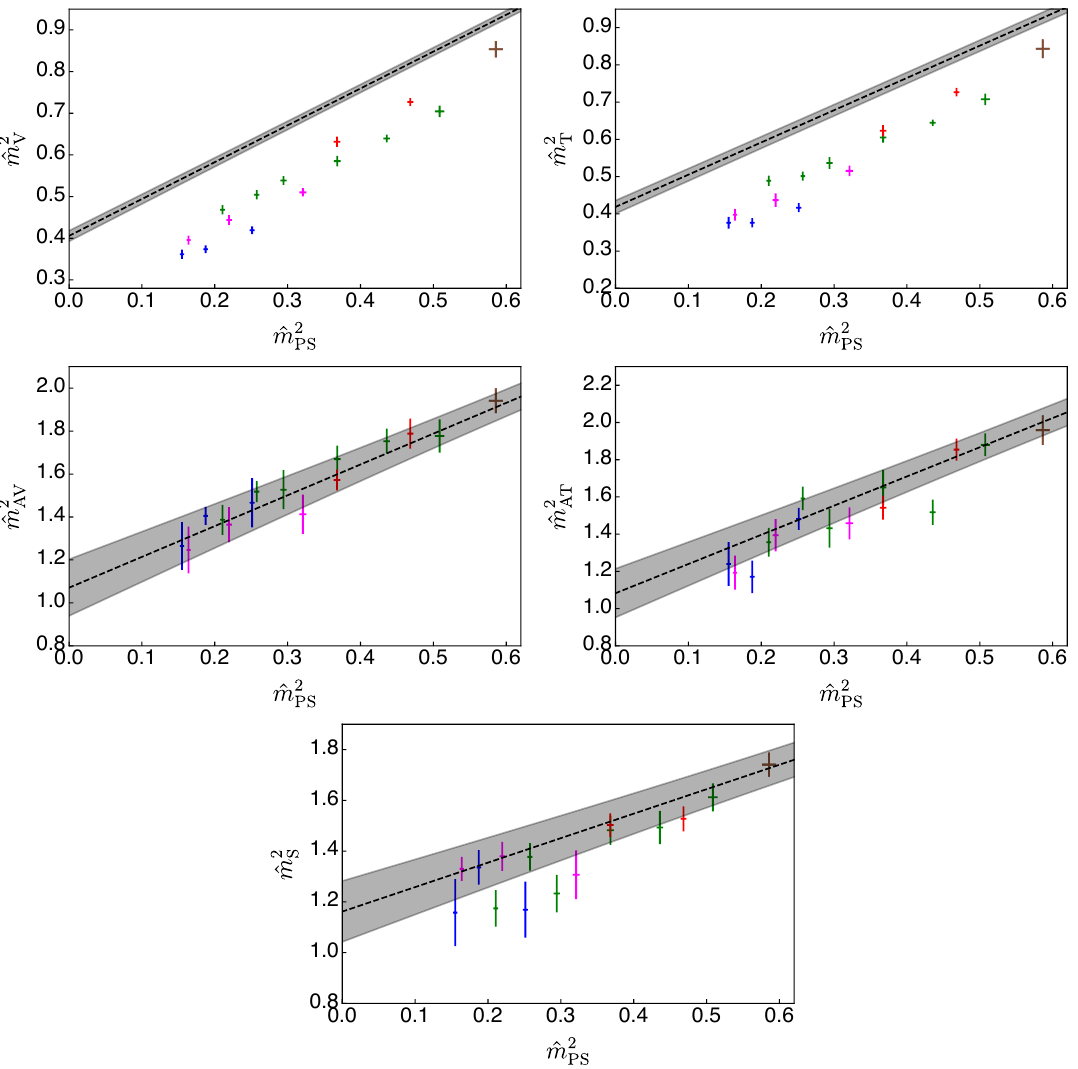
Figure 11. Top to bottom, left to right: masses squared of the vector (V), tensor (T), axial-vector (AV), axial-tensor (AT), and scalar (S) mesons, as a function of the pseudoscalar mass squared ^ m 2 . Various colours denote di(cid:11)erent lattice couplings: (cid:12) = 6 : 9 (blue), 7 : 05 (purple), 7 : 2 (green), PS 7 : 4 (red), and 7 : 5 (brown). The grey bands (the width of which indicates the statistical error) show the results of the continuum and massless extrapolations after subtracting the discretisation artefact, as discussed in the